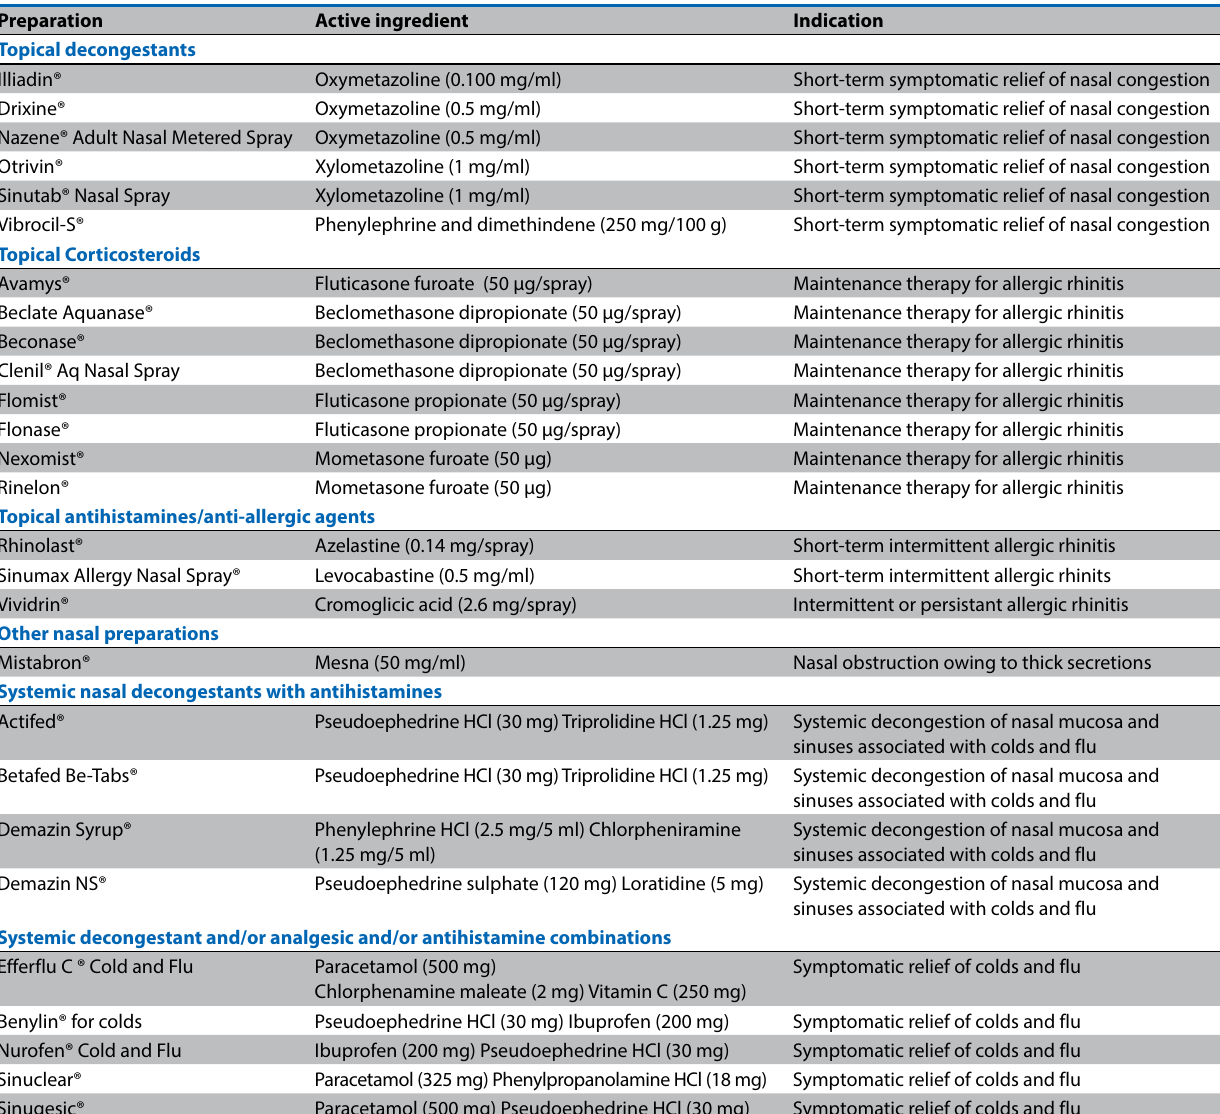
Table 4: Over-the-counter medicine for the treatment of colds and flu 1, 13 . Preparation Active ingredient Indication Topical